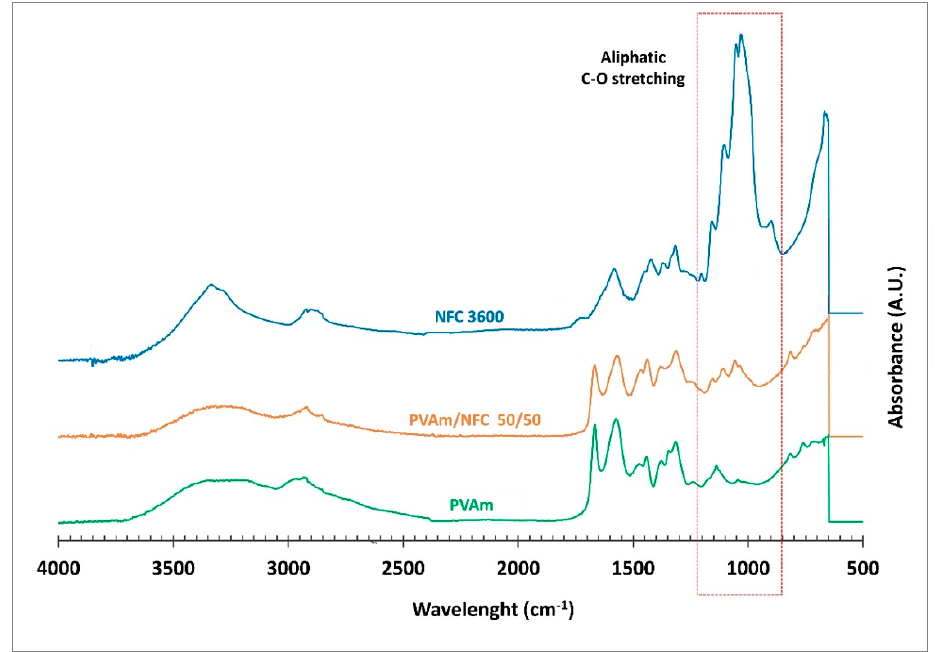
Figure 3. FTIR spectra of cNFC, PVAm and PVAm/cNFC 50/50 blends.